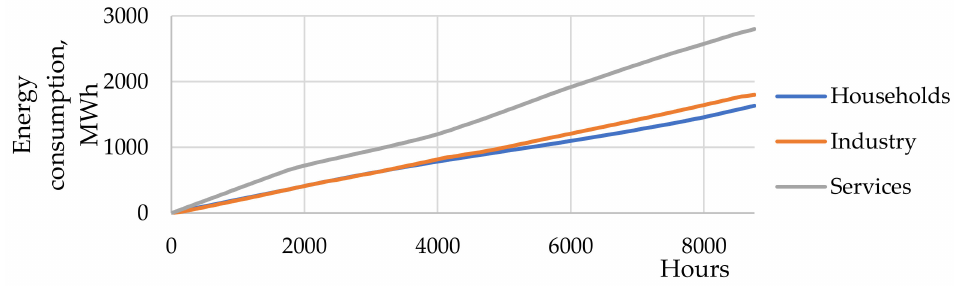
Figure 5. Annual accumulated electricity consumption for different consumer